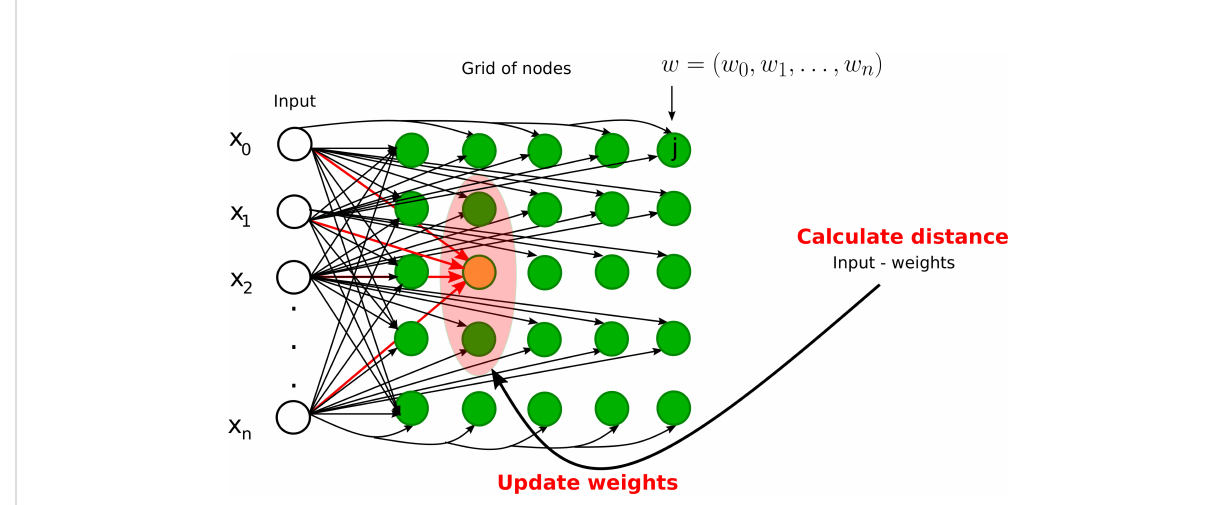
FIGURE 7 Graphical illustrations of self-organizing neural networks. Instance of a Kohonen neural network with n input nodes and a grid of output nodes. Note that each input node is directly connected to a node on the grid. However, we did not draw some of the connections from inputs to the nodes on the grid for clarity. The orange node represents the winner node and the light pink node denotes the neighborhood radius. The weights of the winner node and its neighbors will be updated during the training phase.